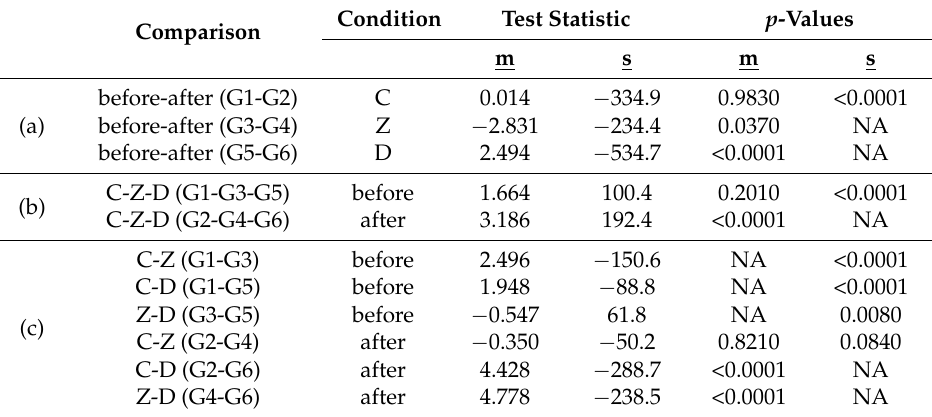
Table 4. Permutation tests for differences in Weibull parameters estimated by